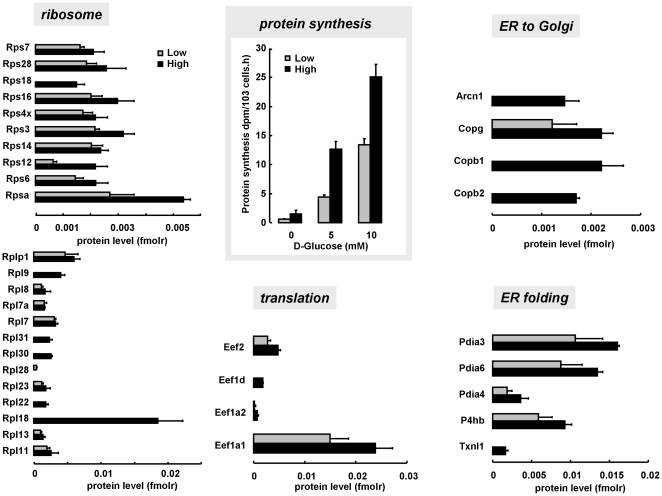
Higher protein synthetic activity of metabolically highly responsive beta cells is associated with concerted up-regulation of protein synthetic machinery.Panels from left to right counterclockwise: molar expression of small (40S) and large (60S) ribosomal subunits, mRNA translation elongation factors, endoplasmic reticulum-proteins involved in NADPH-regulated protein folding (protein disulphide isomerase family, Pdia), and subunits of the coatomer complex, involved in protein trafficking between endoplasmic reticulum and Golgi for regulated secretion. Concerted 50% protein up-regulation is associated to 2-fold higher 3H-Tyrosine incorporation, over 0–10 mM glucose range (blue square inset). Lowly and highly responsive beta cells represented by pale and dark blue bars respectively; absent bars indicate protein level below limit of quantification.